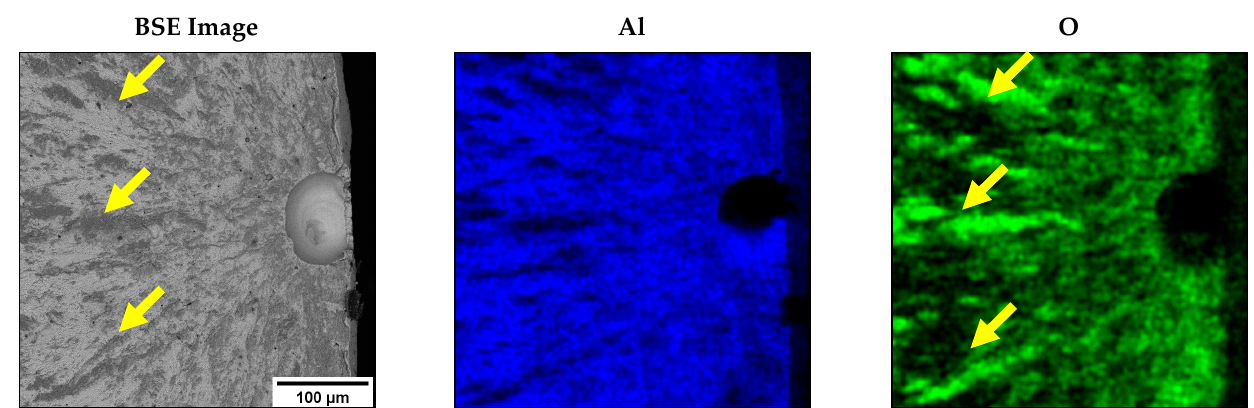
Figure 11. BSE image of the crack initiation zone of the T6R alloy. EDS elemental maps of Al (blue) and O (green). The yellow arrows in the BSE image and the O maps highlight the correspondence between dark (BSE image) and green (O map) areas in the propagation